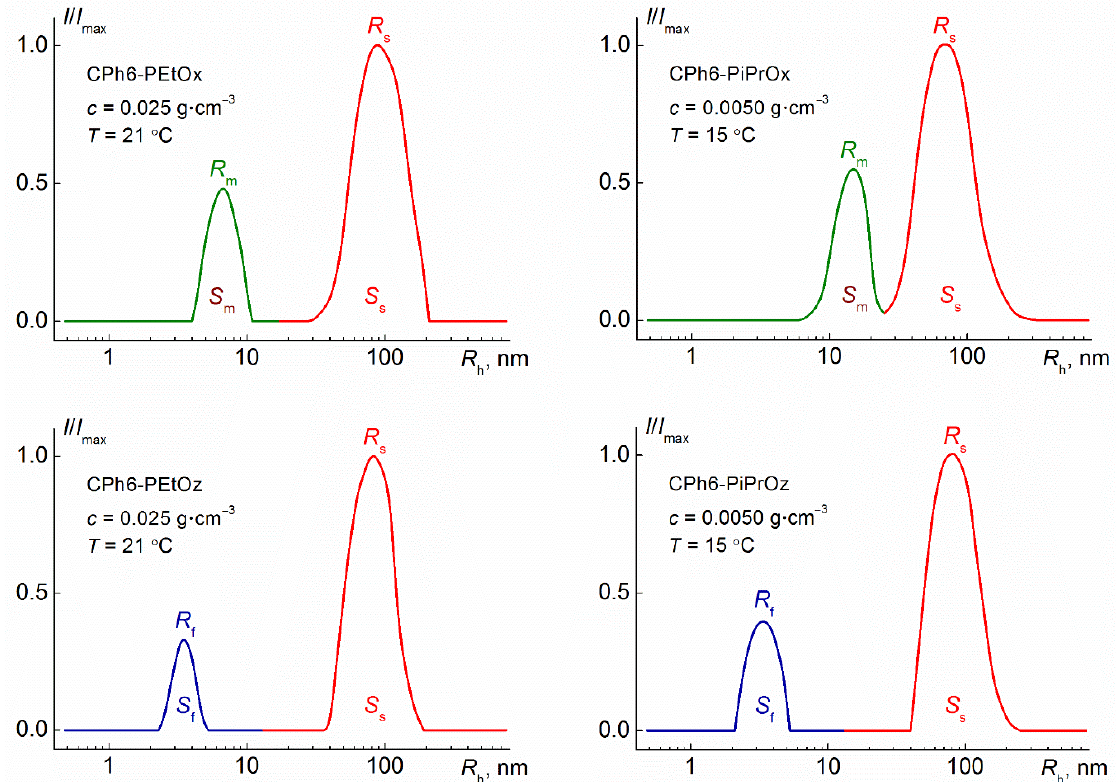
Figure 3. The distributions of light scattering intensity over hydrodynamic radii of scattering species for solutions of star- shaped pseudo-polypeptoids. R f , R m , and R s, are the hydrodynamic radii of macromolecules (fast mode), small aggregates (middle mode) and large aggregates (slow mode), respectively. S f , S m , and S s are contributions of the corresponding modes to the total light